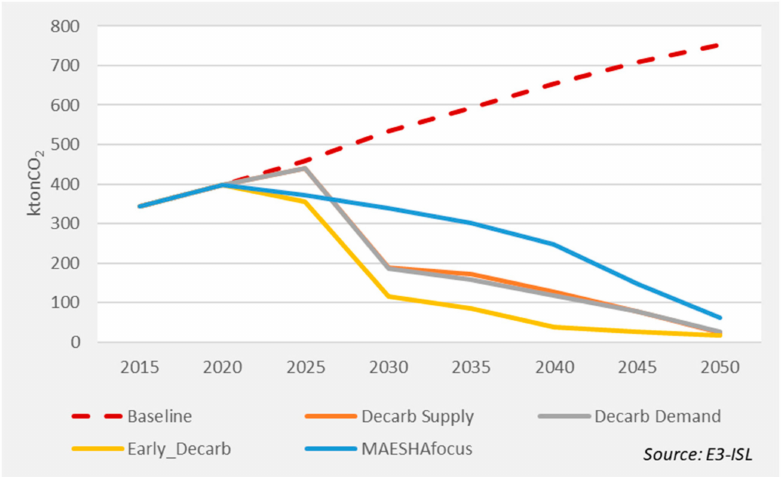
Figure 10. CO 2 emission trajectories by